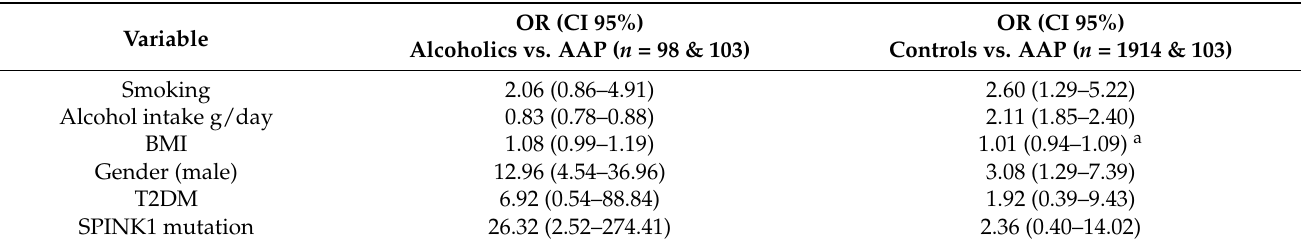
Table 2. Known risk factors for AAP in a binomial regression analysis comparing AAP patients with alcoholics and healthy